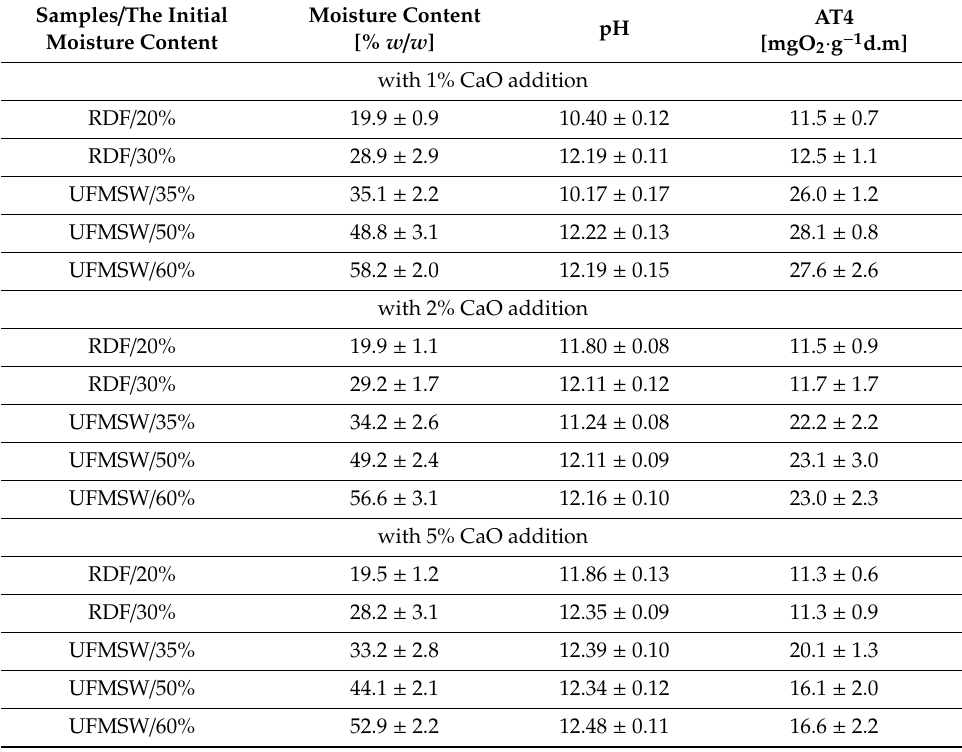
Table 4. Impact of CaO additions on the selected physicochemical properties of analyzed